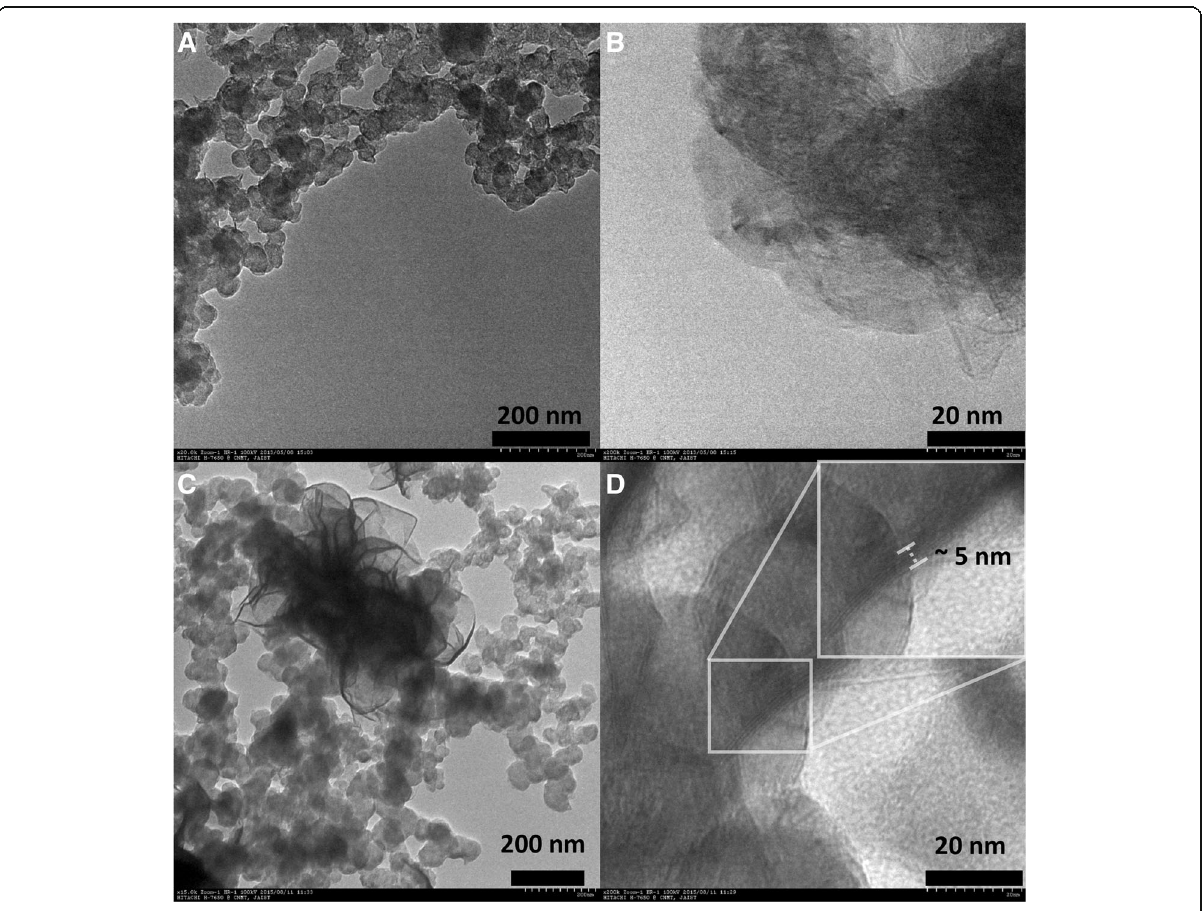
Fig. 2 TEM micrographs of a AB showing interconnected morphology. b Highly layered nature of AB. c MoS 2 nanocrystal showing flower-like morphology. d Layered and transparent morphology of MoS 2 with inset showing a close view of few layers of MoS 2 in the prepared